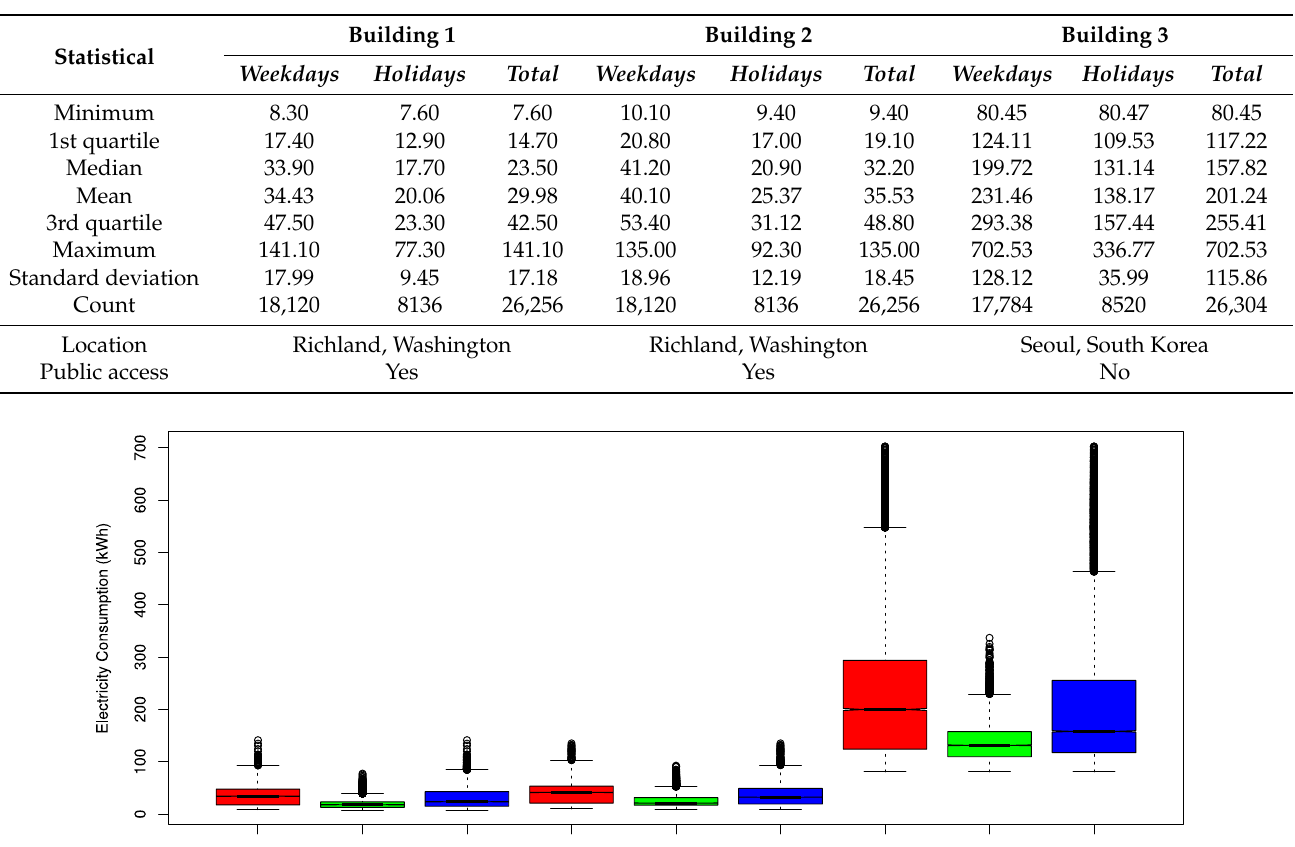
Table 2. Energy consumption statistics of three buildings.